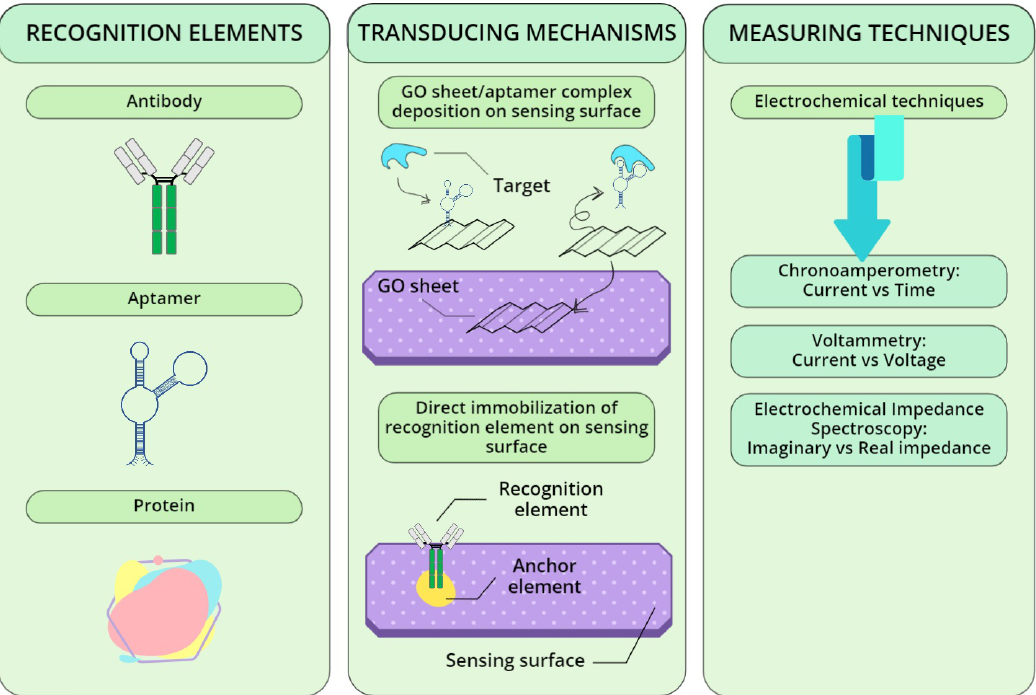
Figure 4. Analysis of the three main aspects of a biosensor realization (i.e., choice of the recognition ele- ment; transducer design implementation; analytical measuring technique) applied to POC-compatible affinity